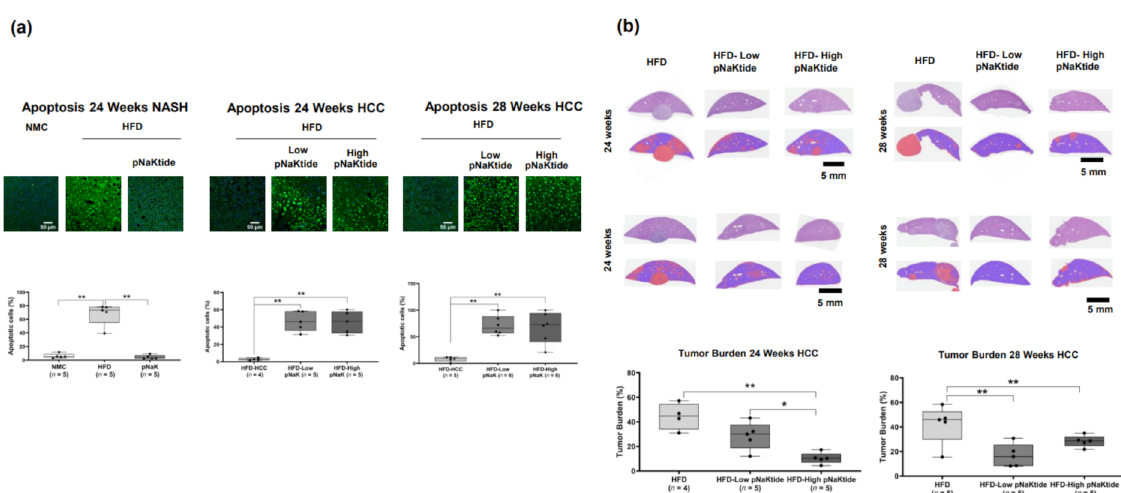
Figure 3. Effect of α 1-Na/K-ATPase signalosome normalization in-vivo on apoptosis and tumor burden. ( a ) The apoptotic activity of livers from animals with NASH was increased significantly when compared with controls (normal mouse chow group) and pNaKtide abrogate such activity on livers from treated animals. In contrast, the apoptotic activity was significantly increased in the NASH-HCC mouse model by an apoptotic ‘switch’ promoted by pNaKtide ( n = 5–6 mice for each group, ** p < 0.01 by ANOVA and Tukey’s Post hoc test, on TUNEL stained liver slides). ( b ) There was a significant decrease in the tumor burden of livers treated with pNaKtide from NASH related HCC at 24 and 28 weeks when compared with livers from untreated animals ( n = 5–6 mice for each group, * p < 0.05, ** p < 0.01). The effect of α 1-NKA signalosome normalization was dose dependent at the 24-week arm of the